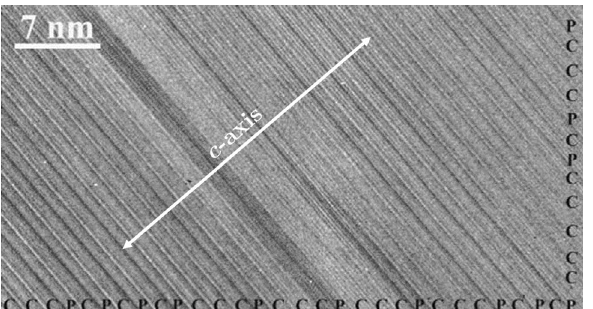
Figure 1. High resolution transmission electron microscope images of interstratified layers of chlorite (C) and pyrophyllite (P). Modified from Wang and Xu 7 .